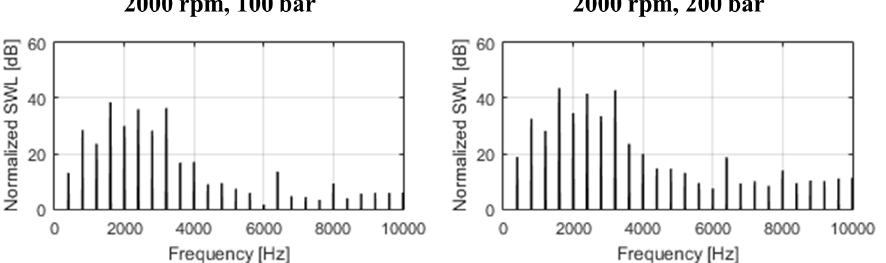
Table 3. Normalized overall sound power levels for the four different operating conditions.